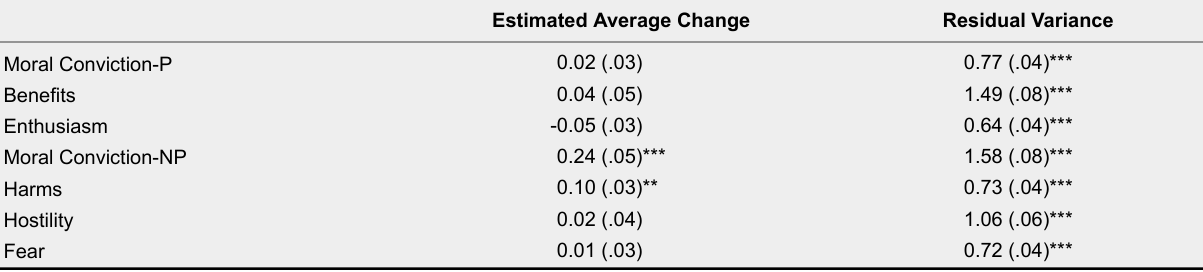
Estimated Time 1 → Time 2 Change and Residual Variance in